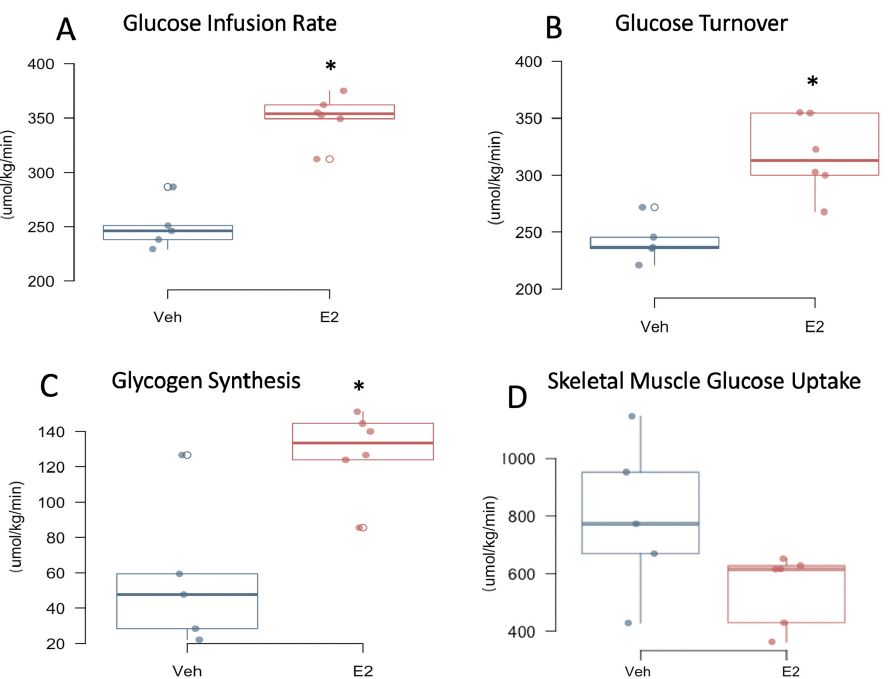
Figure 5. Estradiol increases insulin sensitivity and glucose utilization in female mice on HFD. Mice underwent hyperinsulinemic-euglycemic clamp on days 43–45, a week following jugular vein surgery. Glucose infusion rate ( A ) Glucose turnover ( B ) Glycogen synthesis ( C ) Skeletal muscle glucose uptake ( D ). * indicates differences between E2 (n = 6) and Veh (n = 5) mice * ( p < 0.05, t -test).